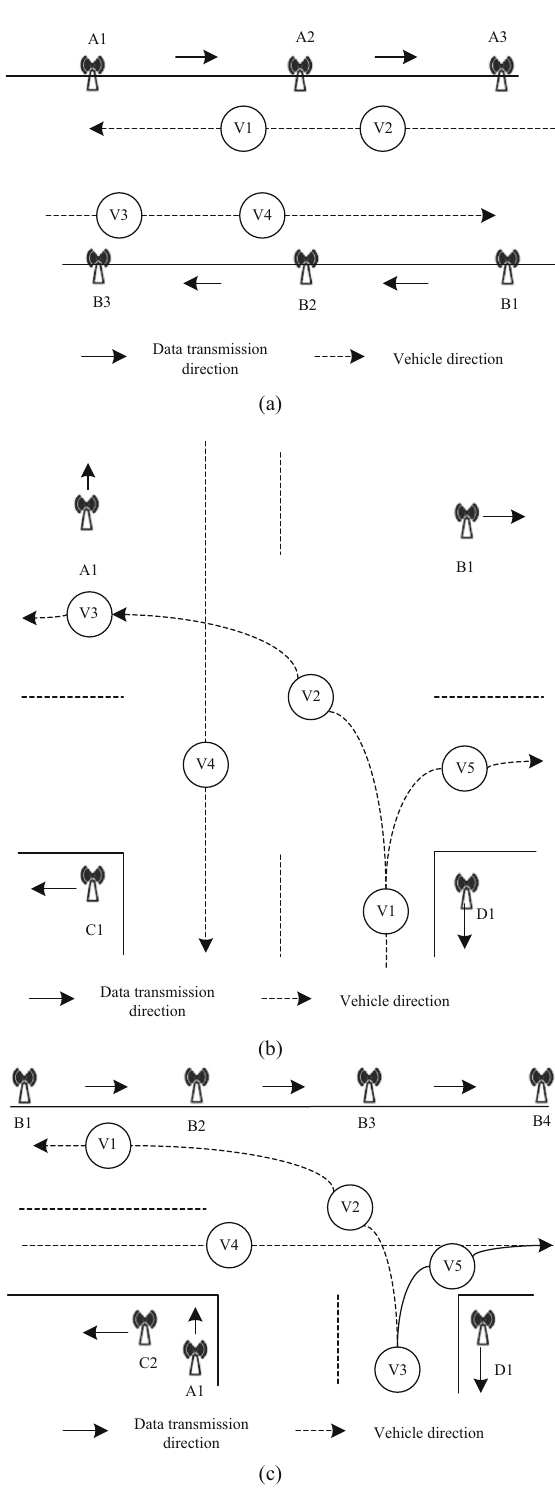
Figure 8: Tra ffi c connection diagram of di ff erent